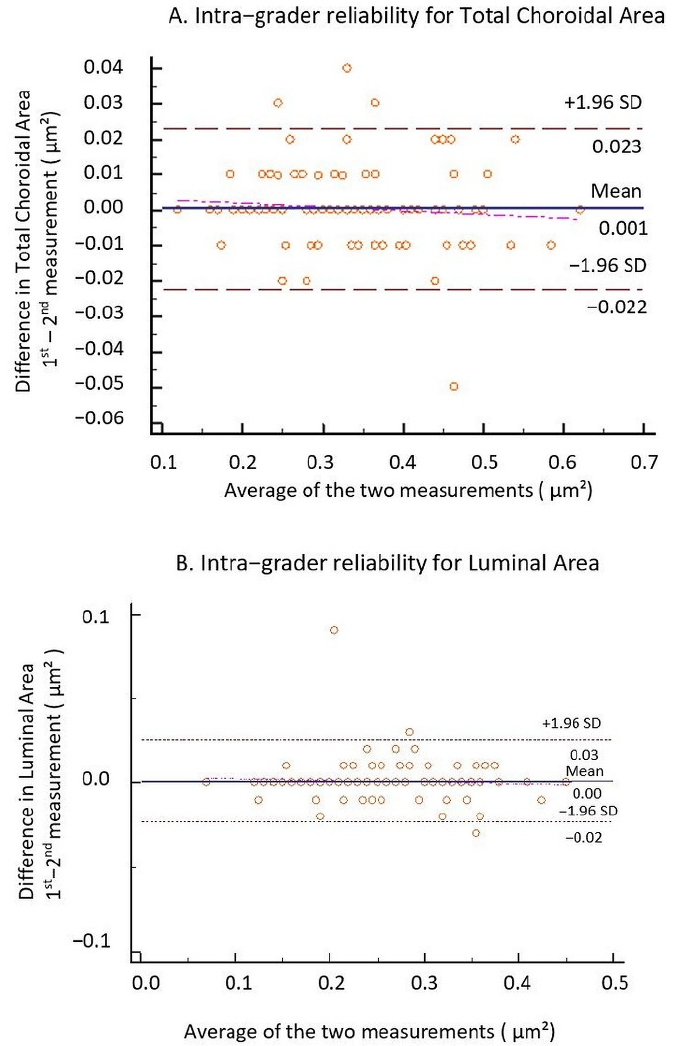
Figure 5. Bland–Altman plots of TCA and LA. ( A ) Intra-grader reliability for TCA and ( B ) intra- grader reliability for LA. The difference was calculated by the 1st measurement minus the 2nd measurement. Pink line represents regression line of difference between 1st and 2nd measurements.